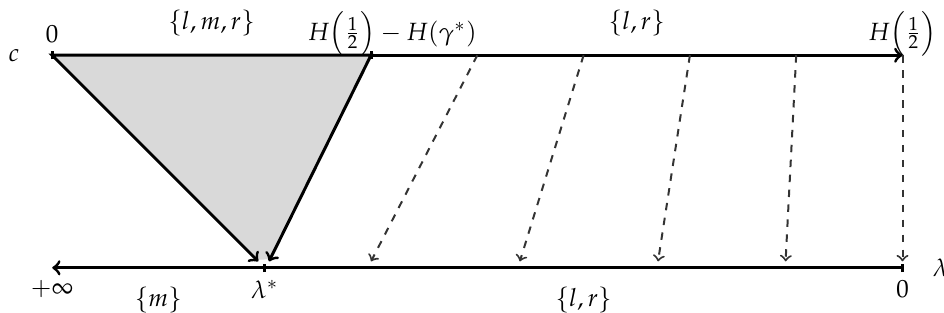
Figure 2. The solutions of problems ( (cid:63)(cid:63) ) (upper line) and ( (cid:63) ) (lower line) from the example with prior µ = 0.5. The arrows between the lines illustrate the mapping from c to the value of the lagrange multiplier λ at the